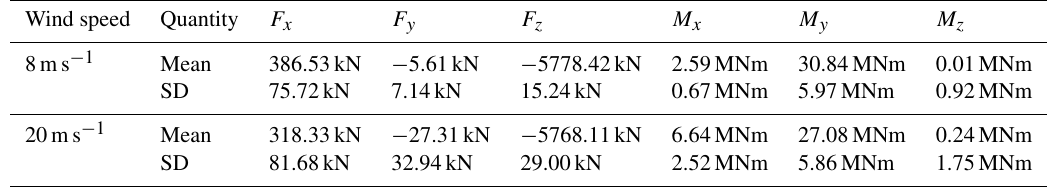
Table 1. Mean and standard deviation (SD) of forces and moments at tower bottom from integrated analysis. Wind speed Quantity F x F y F